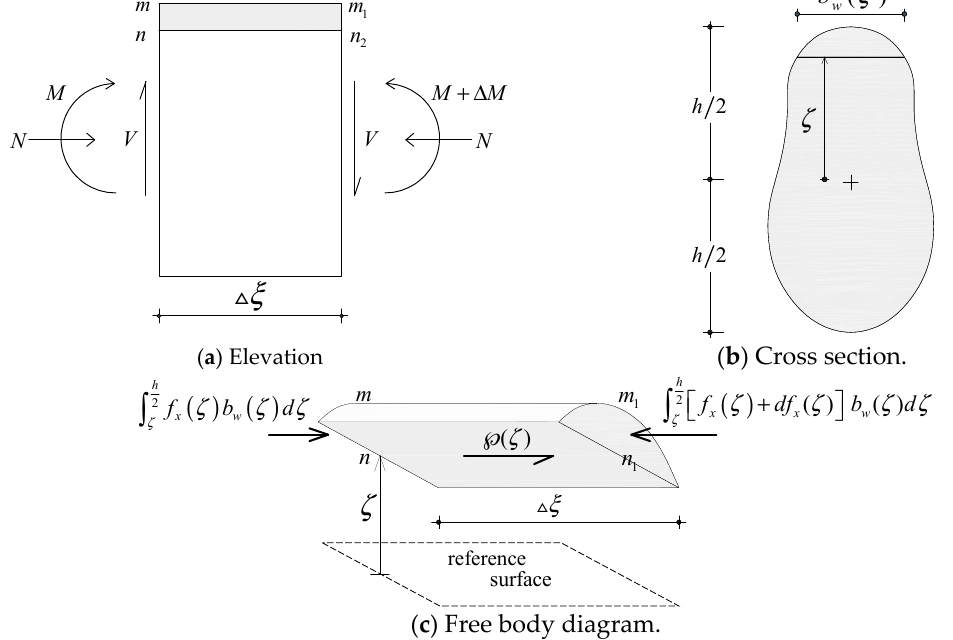
Figure 2. Equilibrium in a beam subjected to non-uniform bending moment.